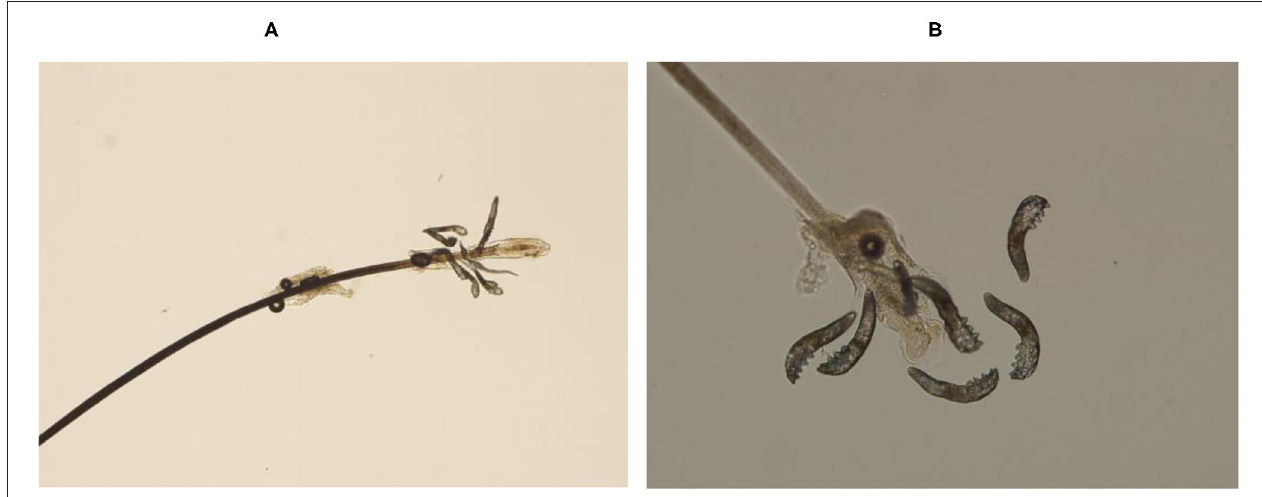
FIGURE 1 | D. folliculorum on the root of the eyelash. Demodex inside dandruff can be observed clearly both at low ( × 100) and high ( × 400) magnification.